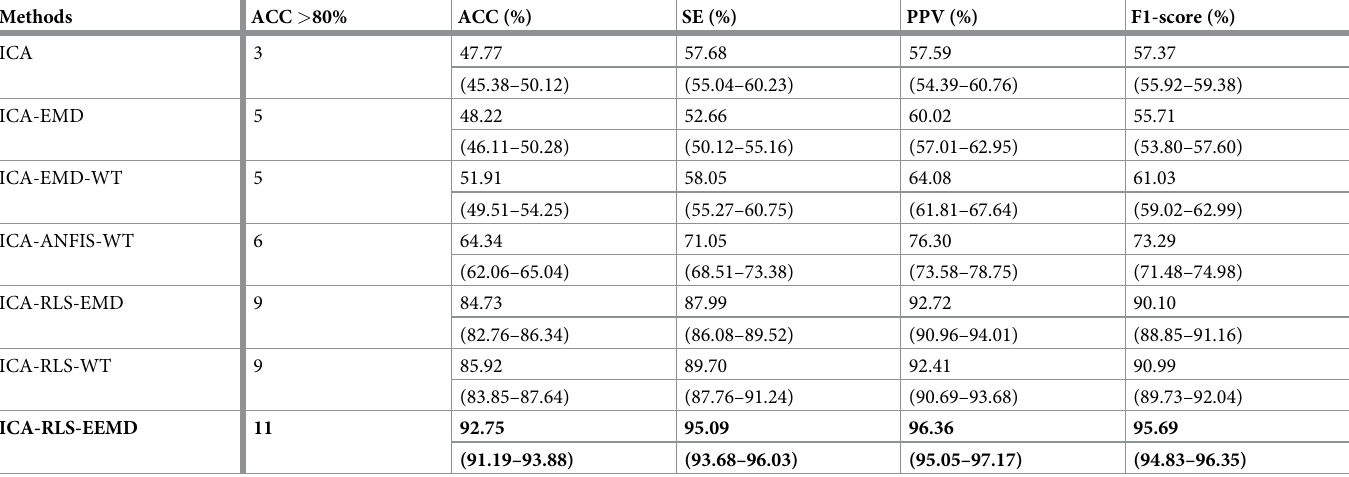
Table 8. Comparison of performance of the methods when extracting the fECG signals from the FECGDARHA database. Second column provides the number of recordings for which ACC > 80% was achieved. Columns three to six show average values calculated for all 12 recordings from the database (the 95% confidence interval is reported in parenthesis).